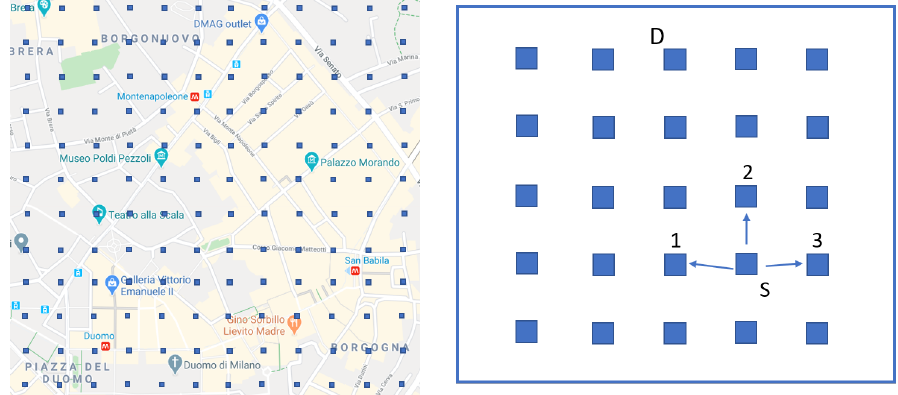
Figure 5. Example of next PoI chosen by user to reach point D from S (Point 2 is the closer to D